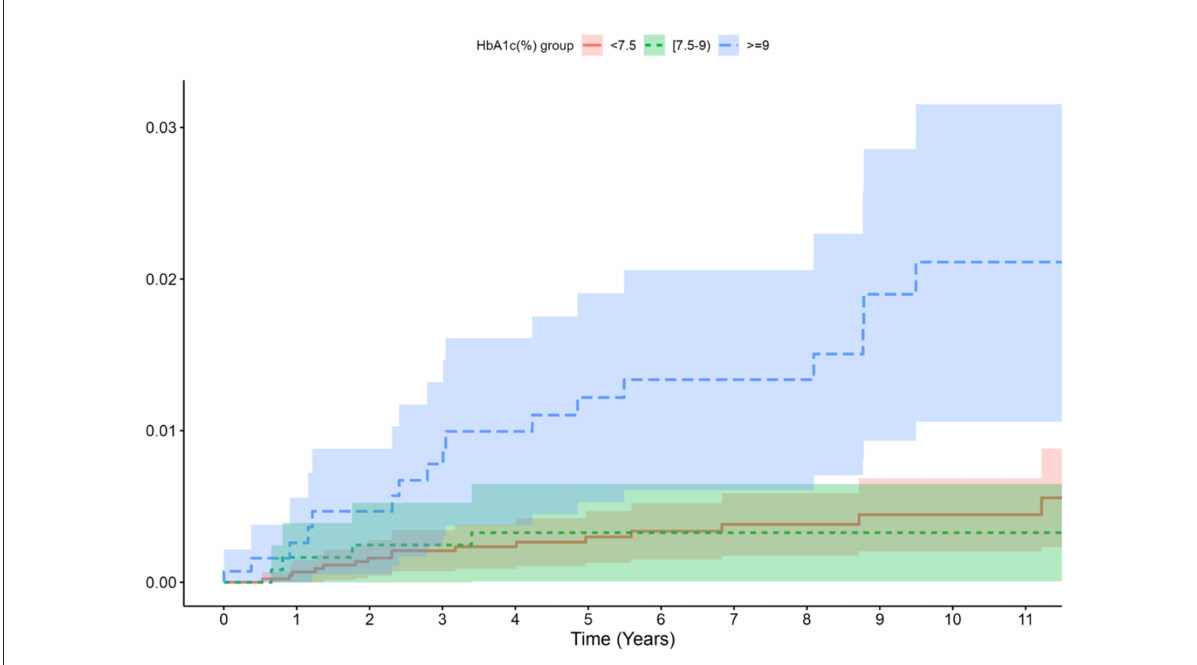
FIGURE2 Cumulative incidence per 100,000 person-year of TB according to HbA1c